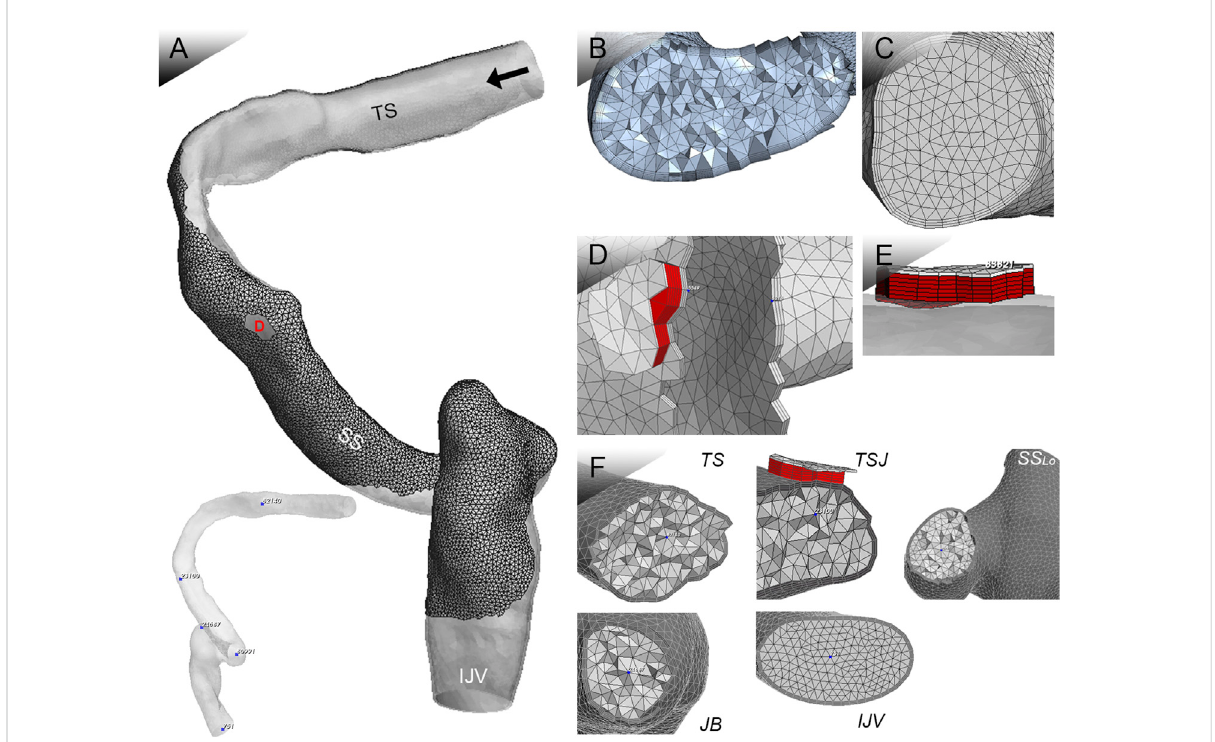
FIGURE 4 Patient-speci fi c3D FE model for coupled CFD studies. TS indicates transverse sinus; TSJ indicates transverse-sigmoid junction;SSLO indicates the lower curve of the sigmoid sinus; JB indicates jugular bulb; and IJV indicates internal jugular vein. Black arrow indicates fl ow direction. (A) Ipsilateraltransverse-sigmoidsinusmodel,locationsofvirtualmicrophones,andtheDopplervelocityspectrum. (B) Meshof3Dgeometricmodelfor fl ow simulation. (C) Mesh of 3D geometric model for acoustic simulation. (D) and (E) Mesh of the dura mater and dehiscent sigmoid plate. (F) Cross-sectional displacement of locations of virtual microphones.